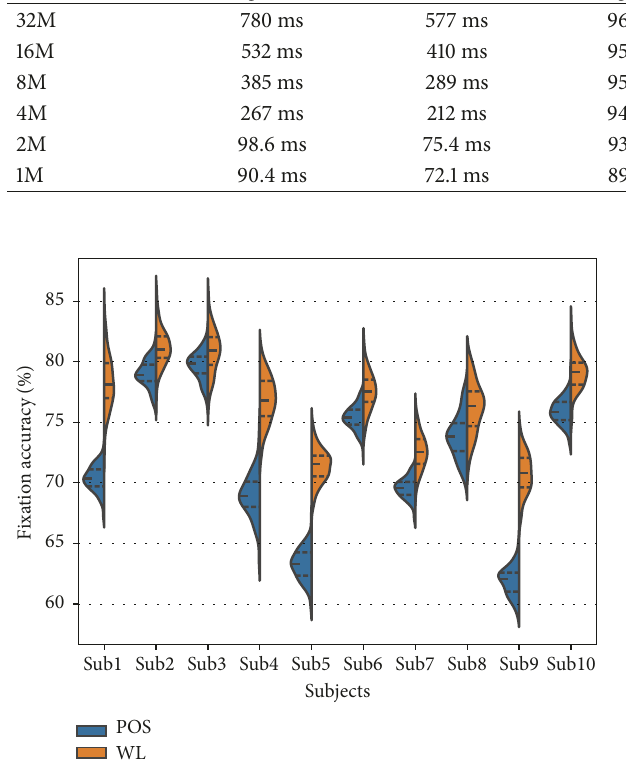
Figure 4: Performance on the fixation prediction task for various subjects using the POS feature or the WL feature.